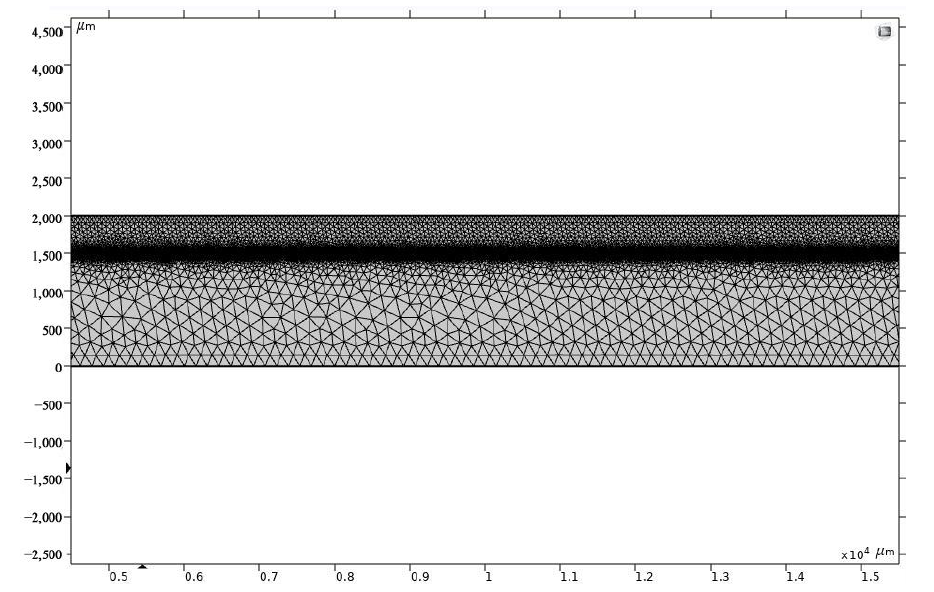
Figure 7. Meshing of the model structure of copper plated on a silicon wafer. Table 2. The input parameters of material and laser.